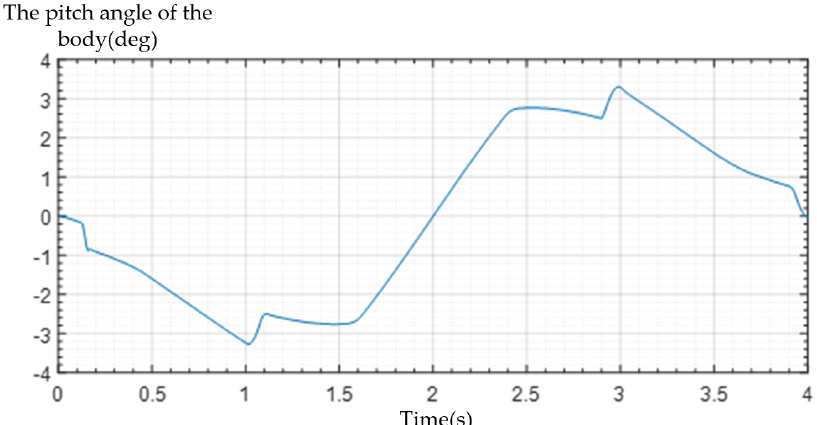
Figure 16. Pitch angle changes in coordinated